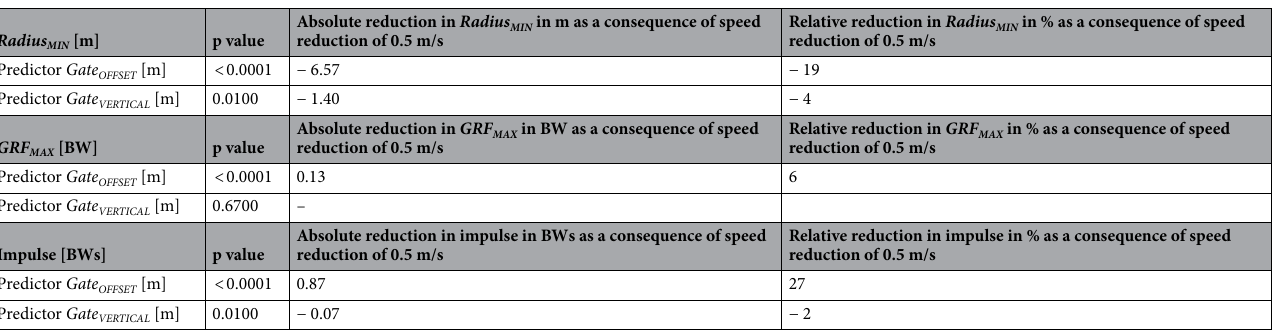
Table 3. Results showing what effect reductions in speed ( ∆Speed ) of − 0.5 m/s through course setting adjustments have on Radius MIN , GRF MAX and impulse. The results must be read as follows: e.g. an increase of